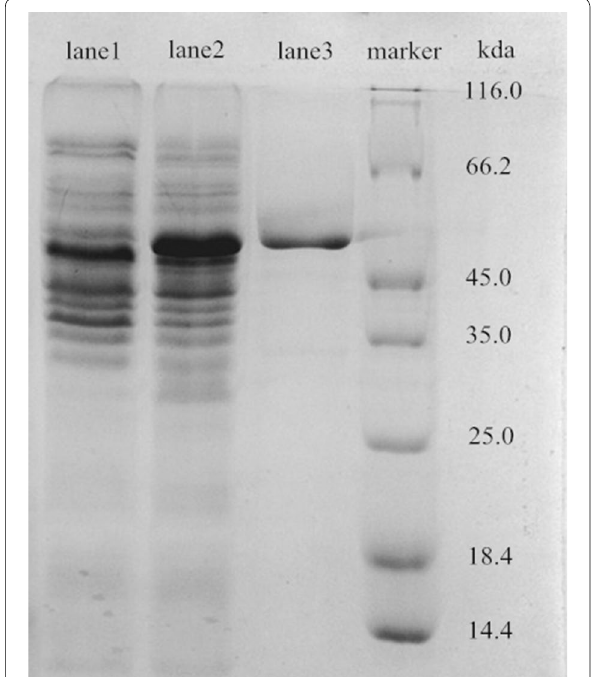
Fig. 2 SDS‑PAGE analysis of expression products by E. coli BL21 (DE3) pLysS(pGEX‑ accr ): lane 1 crude cell extract of non‑IPTG‑induced recombinant strain; lane 2 crude cell extract of IPTG‑induced recombi‑ nant strain; lane 3 the purified recombinant AcCR